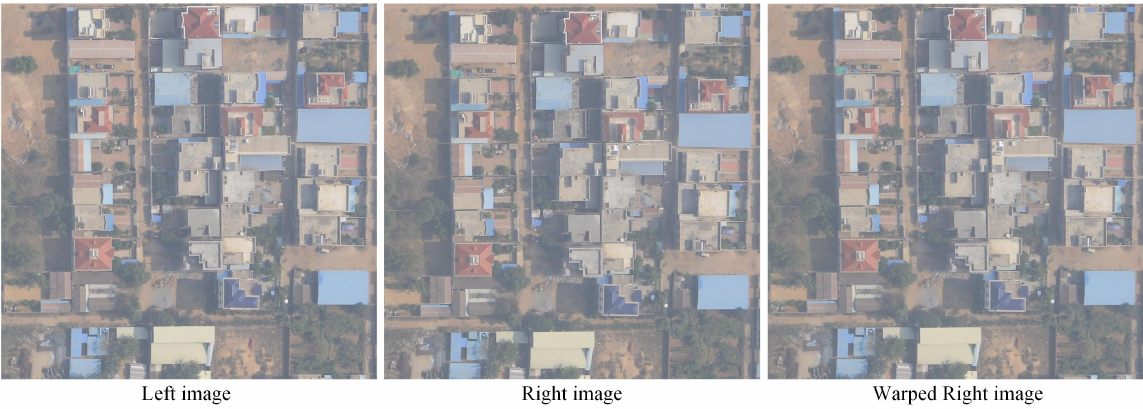
Figure 4. UAV test images and image coregistration.